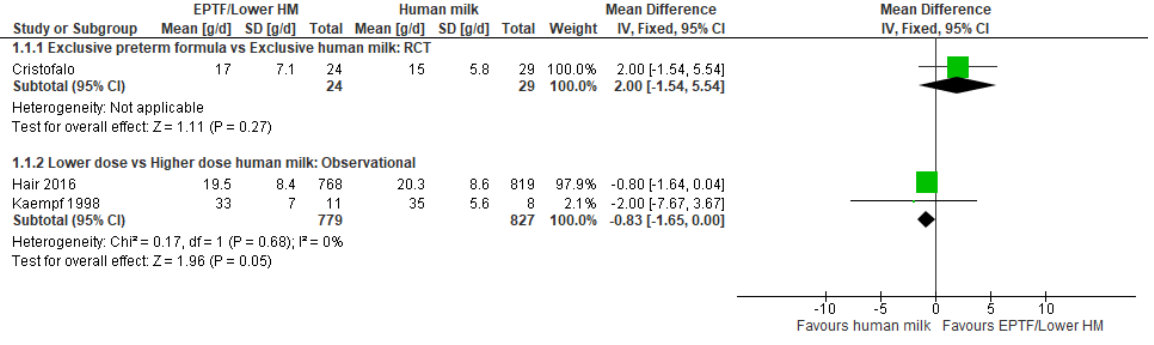
Figure 1. Forest plot of mean difference in weight gain (g/d) and human milk intake.